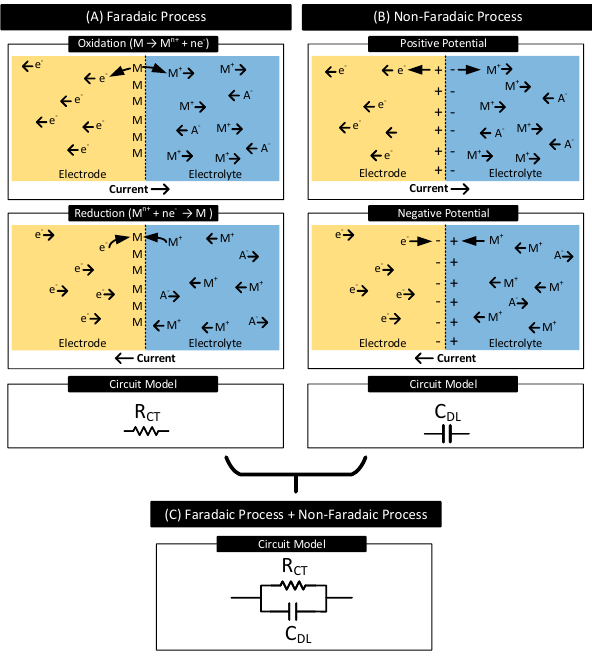
Figure 2. ( A ) Faradaic Process: Oxidation and reduction reactions occur at the electrode–electrolyte interface involving atoms in the electrode ( M ) and cations ( M + ) in the electrolyte, resulting in charge transfer across the interface. Oxidation dominates when current flows from electrode to electrolyte, and reduction dominates when the current direction is the opposite. Resistor R CT models the faradaic process of current transfer. ( B ) Non-Faradaic Process: Charges do not cross the interface; instead, they accumulate across the interface. When the current flows from electrode to electrolyte, the electrode gains a positive charge near the interface and the electrolyte a negative charge. Charges reverse when the direction of the current is the opposite. Capacitor C DL models the non-faradaic process of current transfer. ( C ) Resistor R CT in parallel to capacitor C DL models the interfaces which support both faradaic and non-faradic processes of current